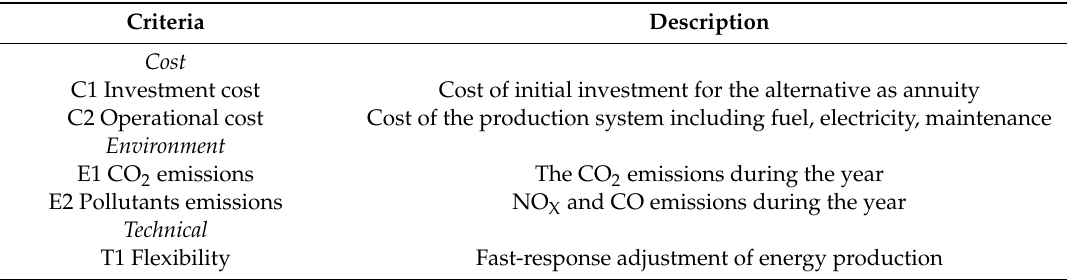
Table 1. Criteria chosen to evaluate alternatives for the case